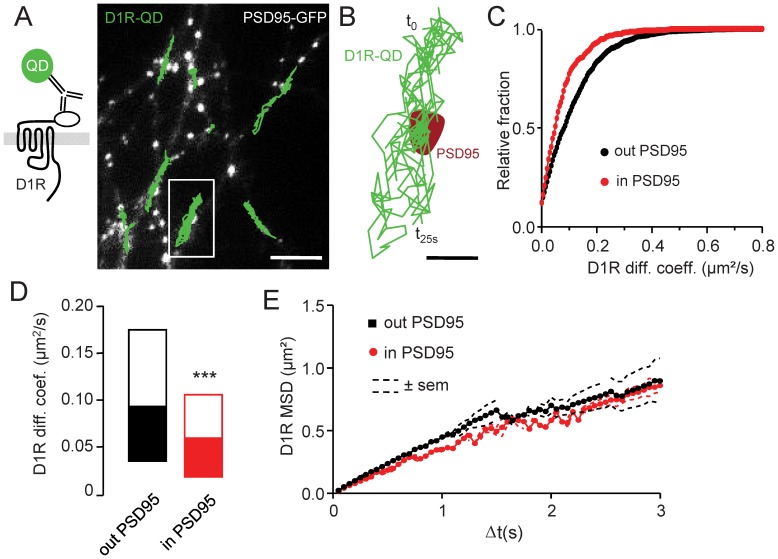
D1R surface dynamics in native PSD95-containing synaptic structures.(A) Surface D1R-CFP were labeled with a single Quantum Dot (QD)-antibody complex, allowing single particle tracking (left panel). Representative trajectories (500 frames duration; 20 Hz acquisition rate) of multiple single surface D1R (green traces) recorded on a PSD95-GFP expressing hippocampal neuron (right panel, scale bar = 5 µm). (B) Representative single D1R trajectory crossing a PSD95-GFP cluster (red area). This is a magnification of the white line squared region of the left picture (scale bar = 1 µm). (C) Frequency distribution of the instantaneous diffusion coefficients of surface D1R either inside or outside of PSD95-GFP clusters. Note the shifted distribution toward lowerD1R diffusion coefficients inside synaptic areas when compared to those located in the extrasynaptic membrane (n = 1784 and 632 trajectories, respectively). (D) Distribution (median±25–75% range) of the instantaneous diffusion coefficients of surface D1R either inside or outside of PSD95-GFP clusters. The D1R surface diffusion is significantly reduced inside postsynaptic areas, i.e. PSD95 clusters, when compared to those located in the extrasynaptic membrane (n = 1784 and 632 trajectories respectively; P<0.001). (E) Plot of the mean square displacement (MSD, expressed in µm2) versus time of surface D1R trajectories either inside or outside of PSD95-GFP clusters (n = 1784 and 632 trajectories respectively). Note that synaptic and extrasynaptic D1R have similar diffusion behavior without increased confinement inside synapses.